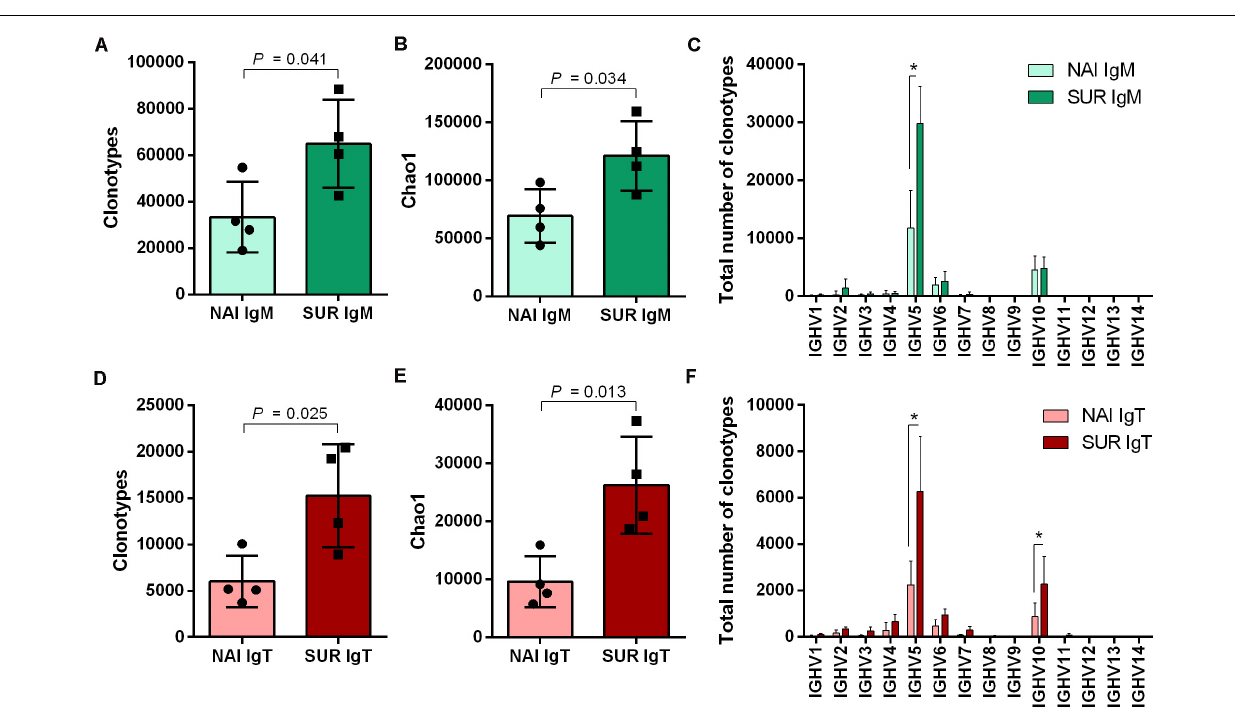
FIGURE 5 | Clonotype diversity and V family usage. Number of unique IgM (A) and IgT (D) clonotypes detected in the anterior intestine of the fish that acted as serum donors in the passive immunization trial. NAI fish did not have parasite-specific IgM in serum, whereas SUR fish had survived an infection with Enteromyxum leei and had high levels of circulating parasite specific IgM. The diversity of the clonotypes sequenced for IgM (B) and IgT (E) was also evaluated using the Chao1 diversity index. The differential usage of VH-gene families for IgM (C) and IgT (F) was calculated with the assignment against zebrafish sequences. Bars represent the average number (mean ± SD) on unique sequences for n = 4 fish. Asterisks represent statistical differences between NAI and SUR groups at P <